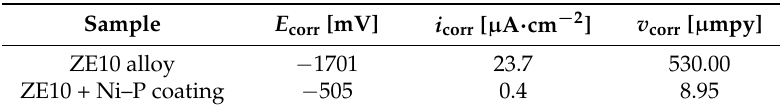
Table 3. Corrosion parameters of the ZE10 magnesium alloy and the ZE10 alloy with a deposited Ni–P